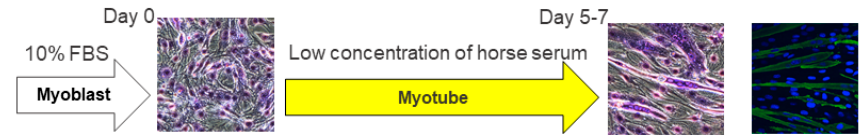
Figure 2. General protocol for mouse skeletal C2C12 myoblast differentiation to myotubes. The immortal line of mouse skeletal myoblasts is kept in culture, avoiding high confluence culture conditions. Replacement of C2C12 myoblast culture medium with growth/differentiation medium containing the lower concentration of horse serum for five to seven days promoted differentiation to C2C12 myotube, which are fused with each other and represent a polynuclear syncytial morphology, as shown with Giemsa staining (left and middle panels) and immunofluorescence staining with antibody against myosin heavy chain and Höchst 33,258 (right panel). FBS: fetal bovine serum.